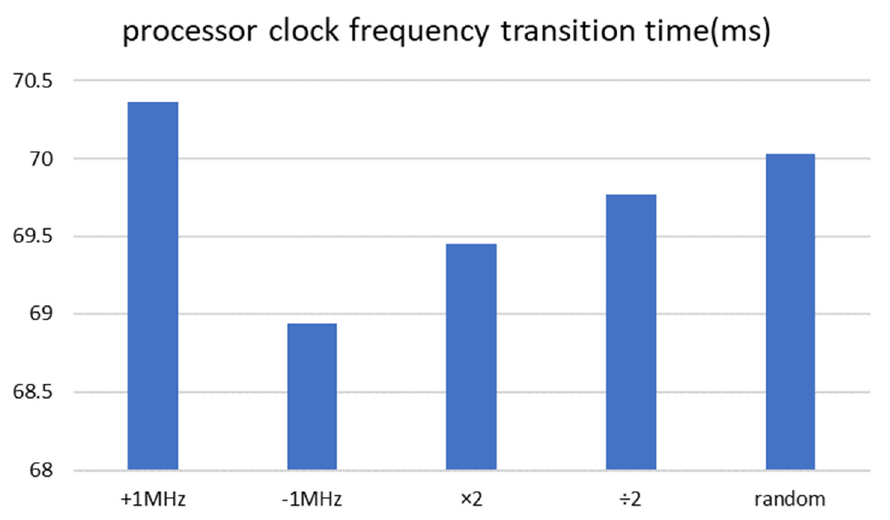
Figure 9. Time overhead of the processor clock frequency transitions for STM32F407.